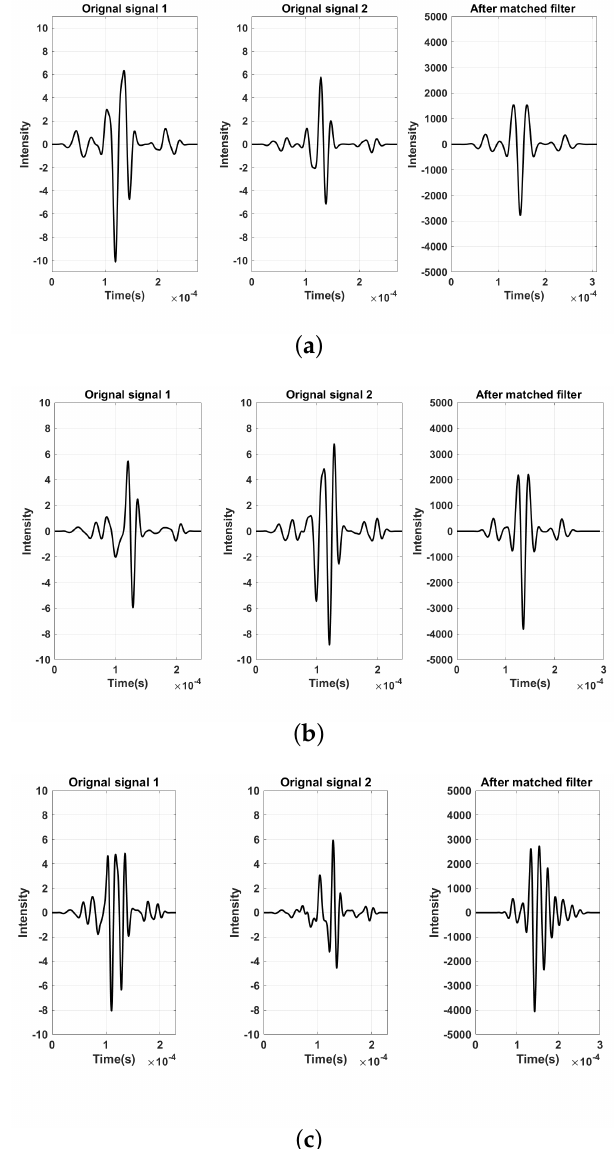
Figure 10. The central line of the 3-bit Barker combined different length Golay code pairs’ simulation results. ( a ) The original and processed B3G2 pair signals. ( b ) The original and processed B3G4 signals. ( c ) The original and processed B3G8 pair